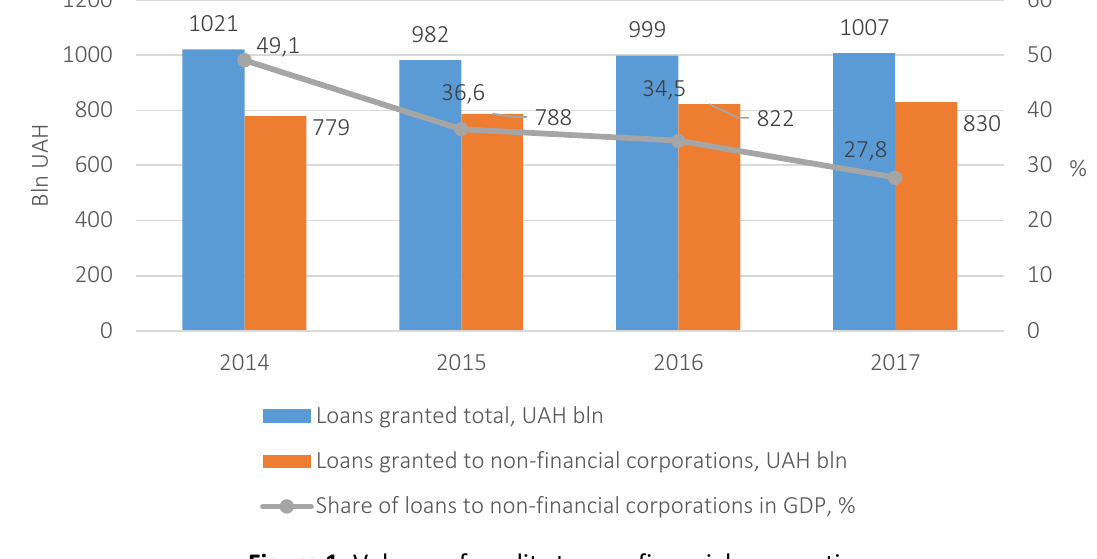
Figure 1. Volume of credits to non-financial corporations and its share in GDP in Ukraine